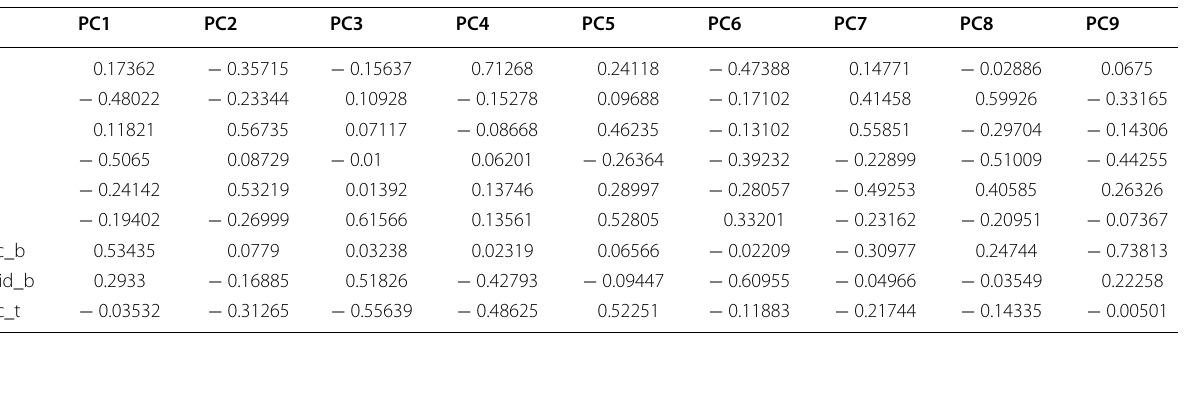
to mesophyll tissues/clear cells. The thickness of a bulliform phytolith refers to the horizontal distance in lateral view, and the length and the width of a bulliform phytolith refer to those on an end profile. To avoid confusion, “the lateral side of end profile” (Motomura et al. 2010) was described as “neighboring border” or “border to the neighboring bul- liform cell/phytolith” in this article.